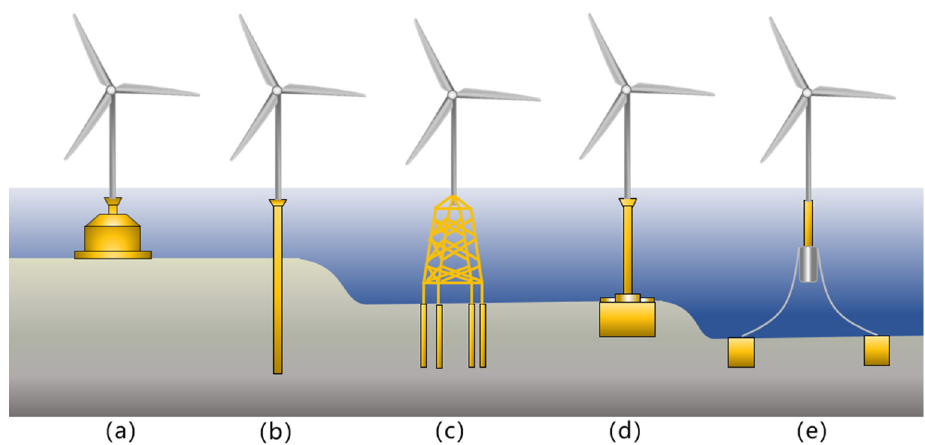
Figure 5. Major foundation types used in OWT design: ( a ) gravity foundation; ( b ) mono-pile; ( c ) jacket foundation piles; ( d ) suction bucket (mono-pod); ( e ) floating wind turbine with anchors (modified from [67]).